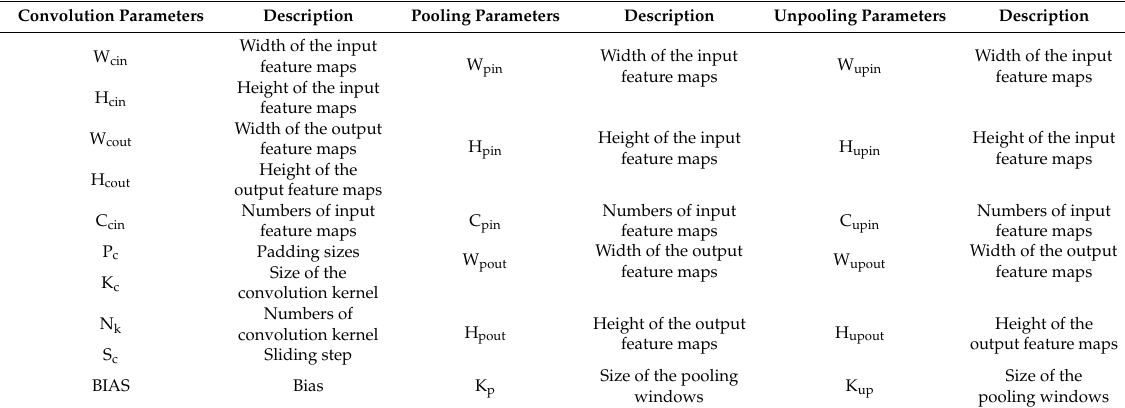
Table 1. Parameters in convolutional, pooling, and unpooling